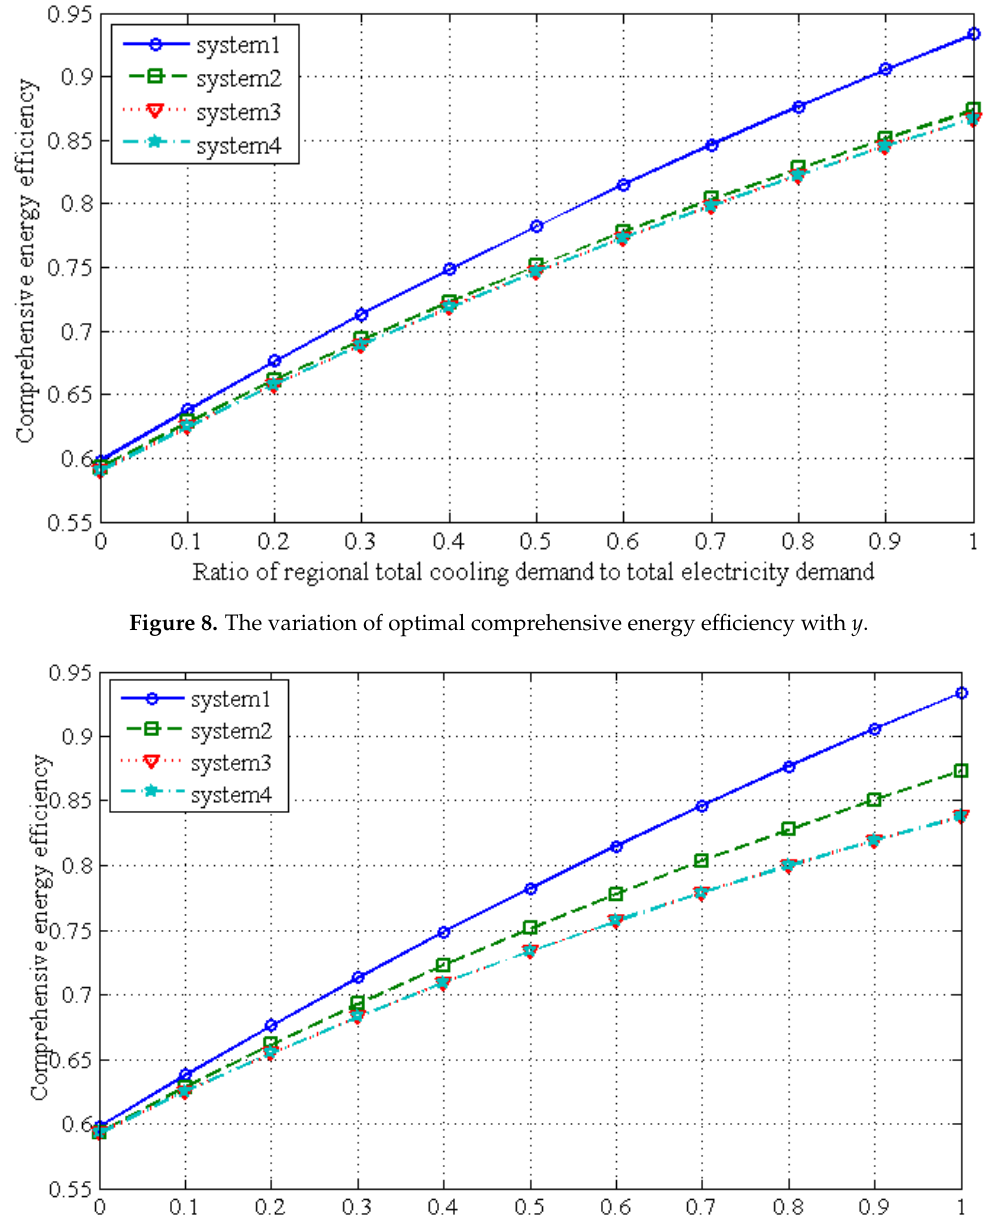
Figure 10. The variation of optimal comprehensive energy efficiency with both y and z. From Figures 8–10, as y and z increase, the optimal comprehensive energy efficiency of the integrated energy system gradually increases and the integrated energy system using the CHP system with a fuel cell as the prime mover will have the best comprehensive energy efficiency compared with the integrated energy system using CHP systems with an internal combustion engine, gas turbine, or steam turbine as the prime mover. The simulation case study for structural optimization has shown that the proposed integrated energy system standardized matrix modeling method and optimization method can be effectively used to decide the system components and their interconnections, i.e., energy flow structure and equipment type.